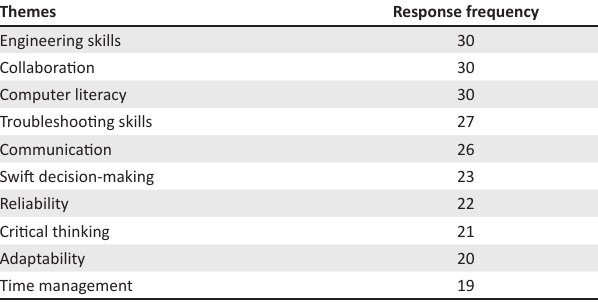
TABLE 7: Ten main competencies needed for collaboration with robots on a production system.